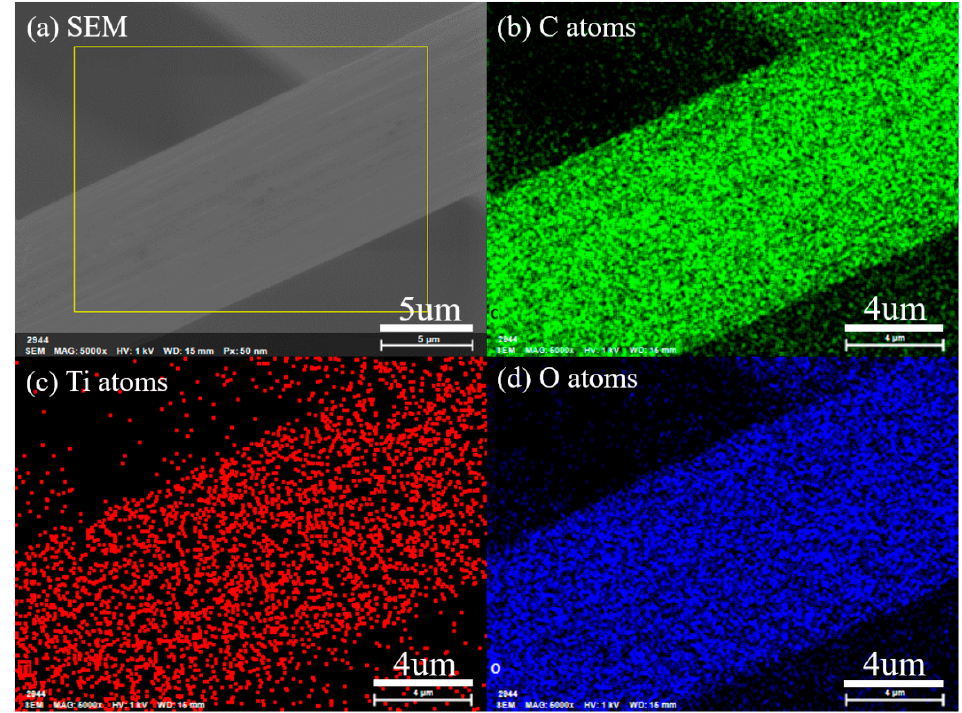
Figure 4. Energy-dispersive X-ray spectroscopy (EDS) mapping analysis of ALD-TiO 2 -modified graphite felt. ( a ) SEM image of the selected-area EDS, and the elemental distribution images of ( b ) C, ( c ) Ti and ( d ) O atoms.